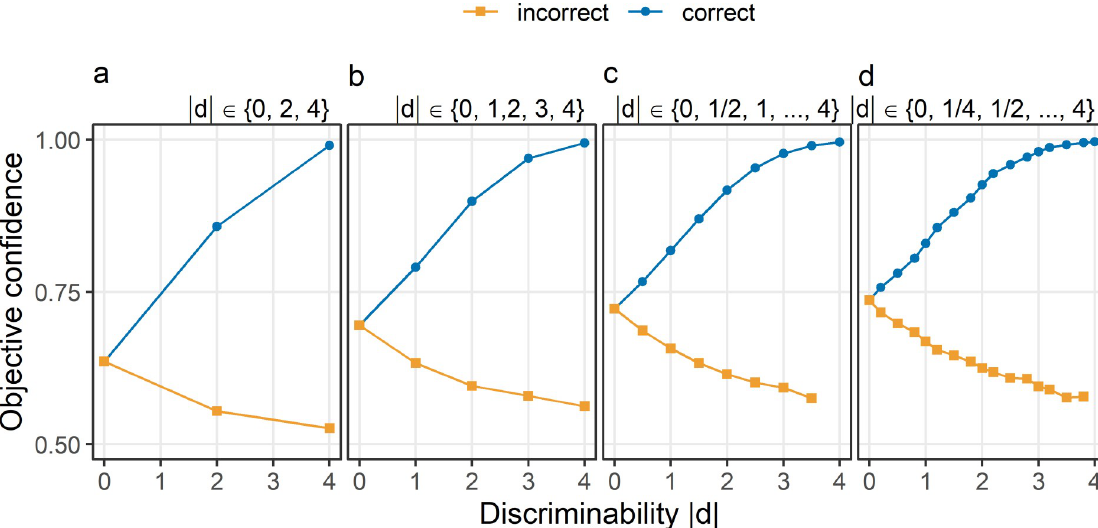
Fig 4. Objective confidence in standard model depending on the number of different levels of discriminability. Confidence (y-axis) is shown as a function of discriminability (x-axis) in correct choices (blue) and incorrect choices (orange). Different panels show different numbers of levels of discriminability |d|, sampled from discrete uniform distributions. Possible values of |d| are 0, 2, and 4 (Panel a), 0, 1, 2, 3, and 4 (Panel b), 0, ½ , 1, ... , 4 (Panel c) or 0, ¼ , ½ , ... , 4 (Panel d). The percept e I was sampled from a normal distribution with a mean equal to the stimulus d and a standard deviation σ I of 1.